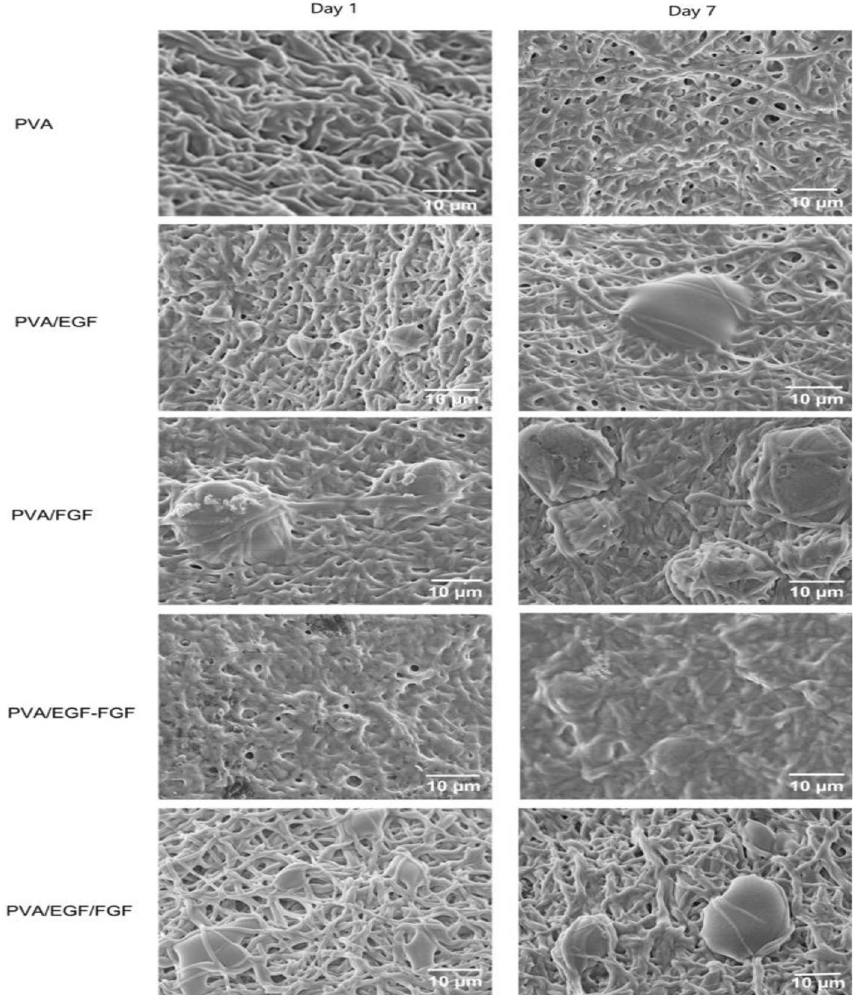
Figure 8. FESEM images of HDFs after day 1 and 7 cultured on